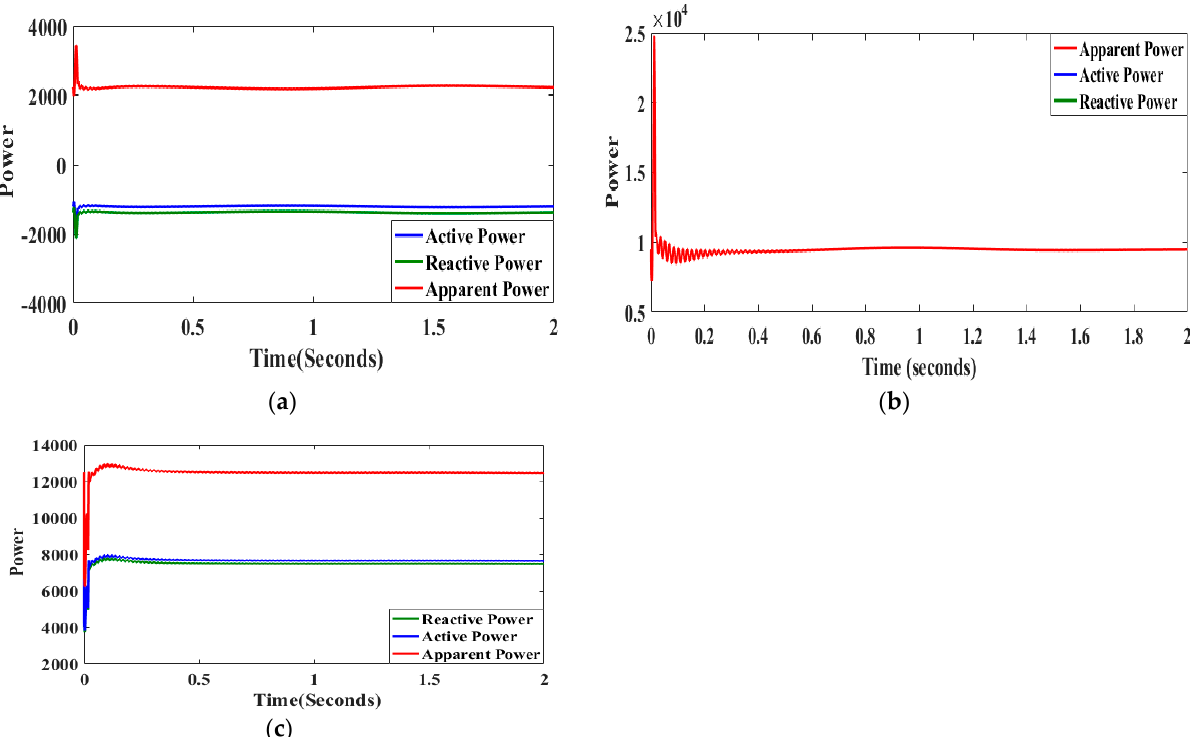
Figure 17. ( a ). Distribution of Power among the DERs. ( b ) Power allocation by grid using 0% convenience of Solar panel. ( c ) Power allocation by DERs using 100% convenience of Solar panel. Table 7. Influence of LI on power loss in generation and distribution system.